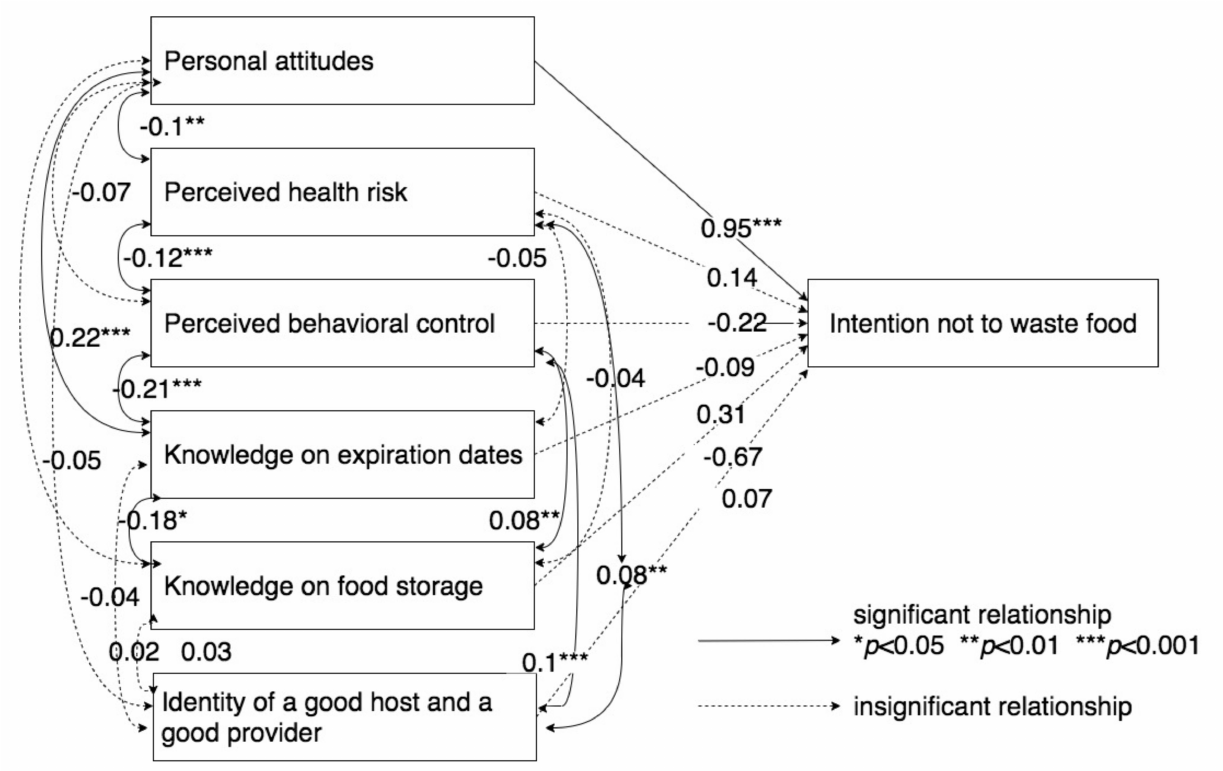
Figure 4. TPB model for segment 2. Full lines mean significant relationship; dotted lines mean insignificant relationship; * p < 0.05; ** p < 0.01; *** p <